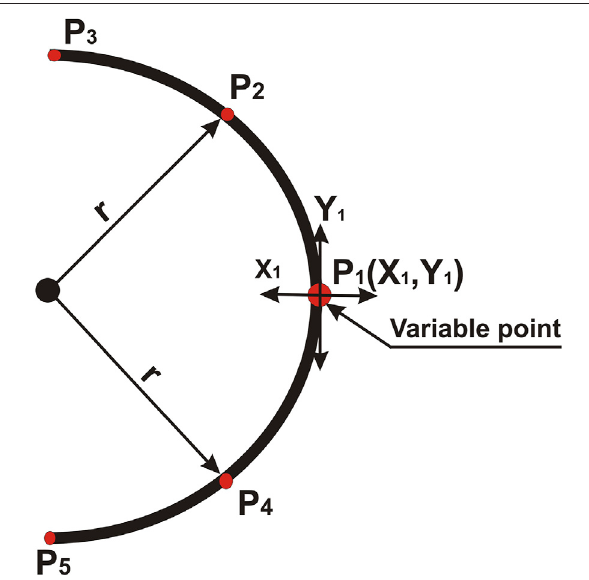
FIGURE 3 | Schematic shape of the optimization